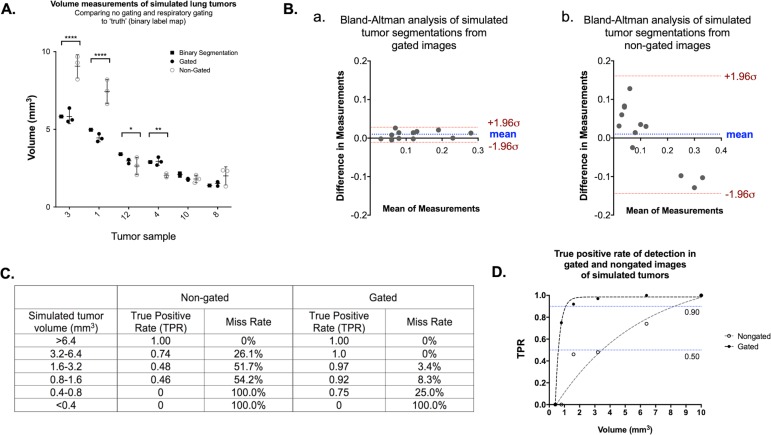
Simulated tumors in CT of free-breathing mouse lungs demonstrate enhanced sensitivity, precision, and volume accuracy when identifying tumors in gated images compared to non-gated images.Variably sized samples of measured simulated lung lesions are shown, including triplicate measures of binary label maps (truth), gated images, and non-gated images (A; ANOVA, *p<0.05). Bland-Altman plots of gated (B.a.) and non-gated (B.b.) tumor segmentations suggest agreement with segmentations of the binary label map, with a size-dependent bias noted in non-gated image segmentations. True positive rate (TPR; sensitivity), Miss rate (False negative rate, or lesions which the reader was unable to correctly identify), Positive predictive value (precision), False discovery rate (False positive rate), and F1 (harmonic mean of precision and accuracy) are shown for gated and non-gated images of simulated tumors of varied sizes (C). TPR as a function of simulated lesion size, with TPRs of 0.9 and 0.5 indicated (blue lines) (D).